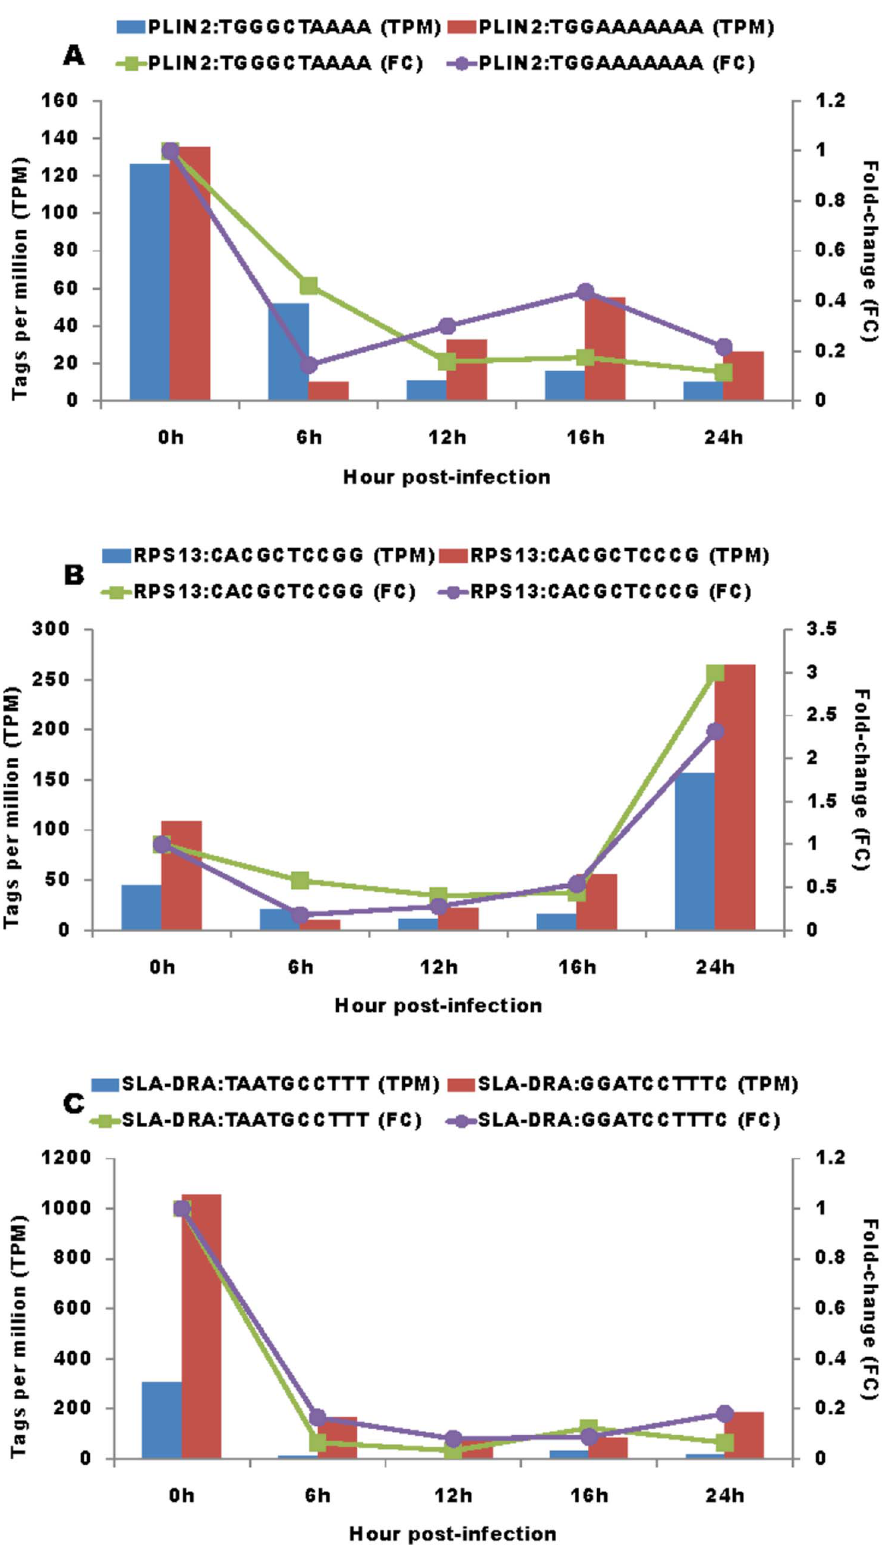
Figure 3. Fold change in TPM for genes with multiple tags due to nucleotide polymorphisms. TPM and fold changes for two tags in PLIN2 (A), RPS13 (B) and SLA-DRA (C) genes representing different alleles at 0, 6, 12, 16 and 24 hours post-infection.